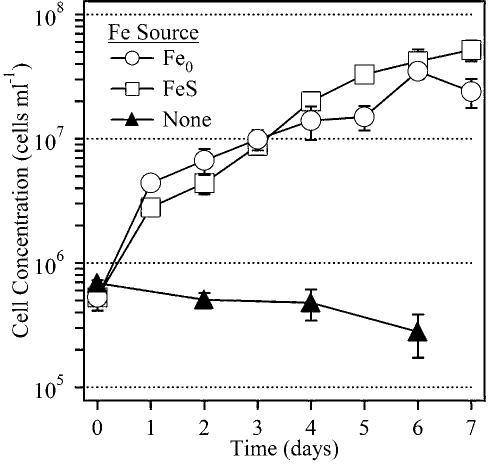
Growth curve of PV-1 on gradient plates with FeS (□) or Fe0 (○) as the iron source.A control (σ) with agarose but no FeS was included. Cell numbers were determined by direct counts and errors are based on duplicate samples.